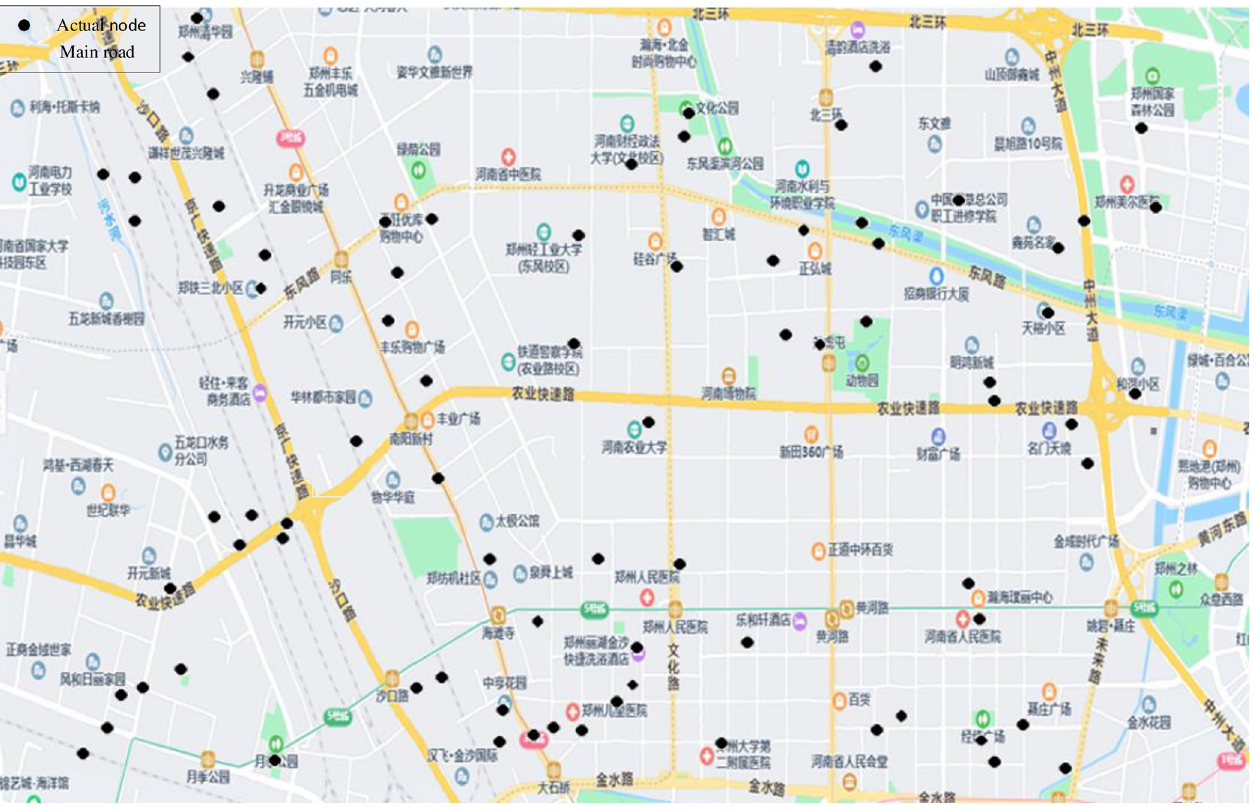
Fig 3. Actual node